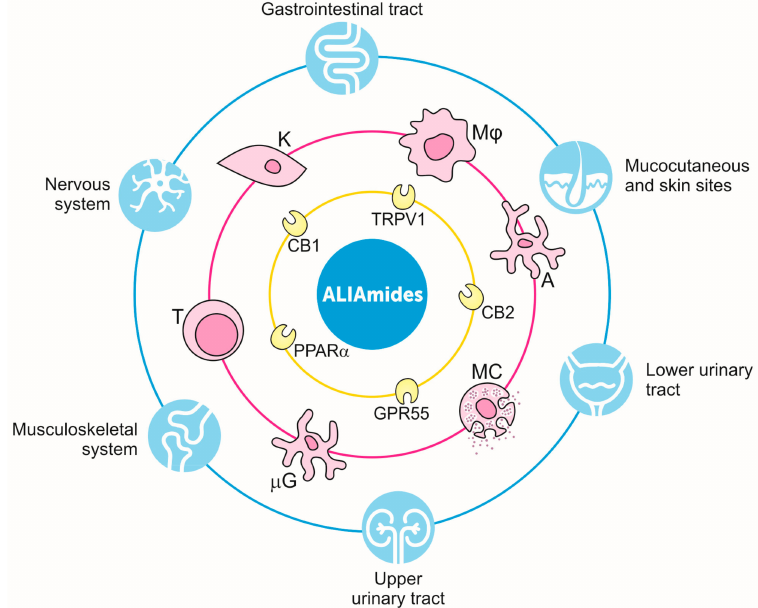
Figure 7. ALIAmides for animal health from a Galileian perspective. Schematic representation of the multitarget function of ALIAmides. Directly and indirectly acting through multiple cannabinoid receptors (yellow ring), PEA and related ALIAmides target di ff erent cell populations (pink ring), supporting health maintenance in a variety of body systems (light blue ring). See text for further details. A, astrocyte; CB1, cannabinoid receptor type 1; CB2, cannabinoid receptor type 2; GPR55, G-protein-coupled receptor 55; K, keratinocyte; MC, mast cell; M Φ , macrophage; µ G, microglia; PPAR α , peroxisome proliferator-activated receptor α ; T, T cells; TRPV1, transient receptor potential vanilloid